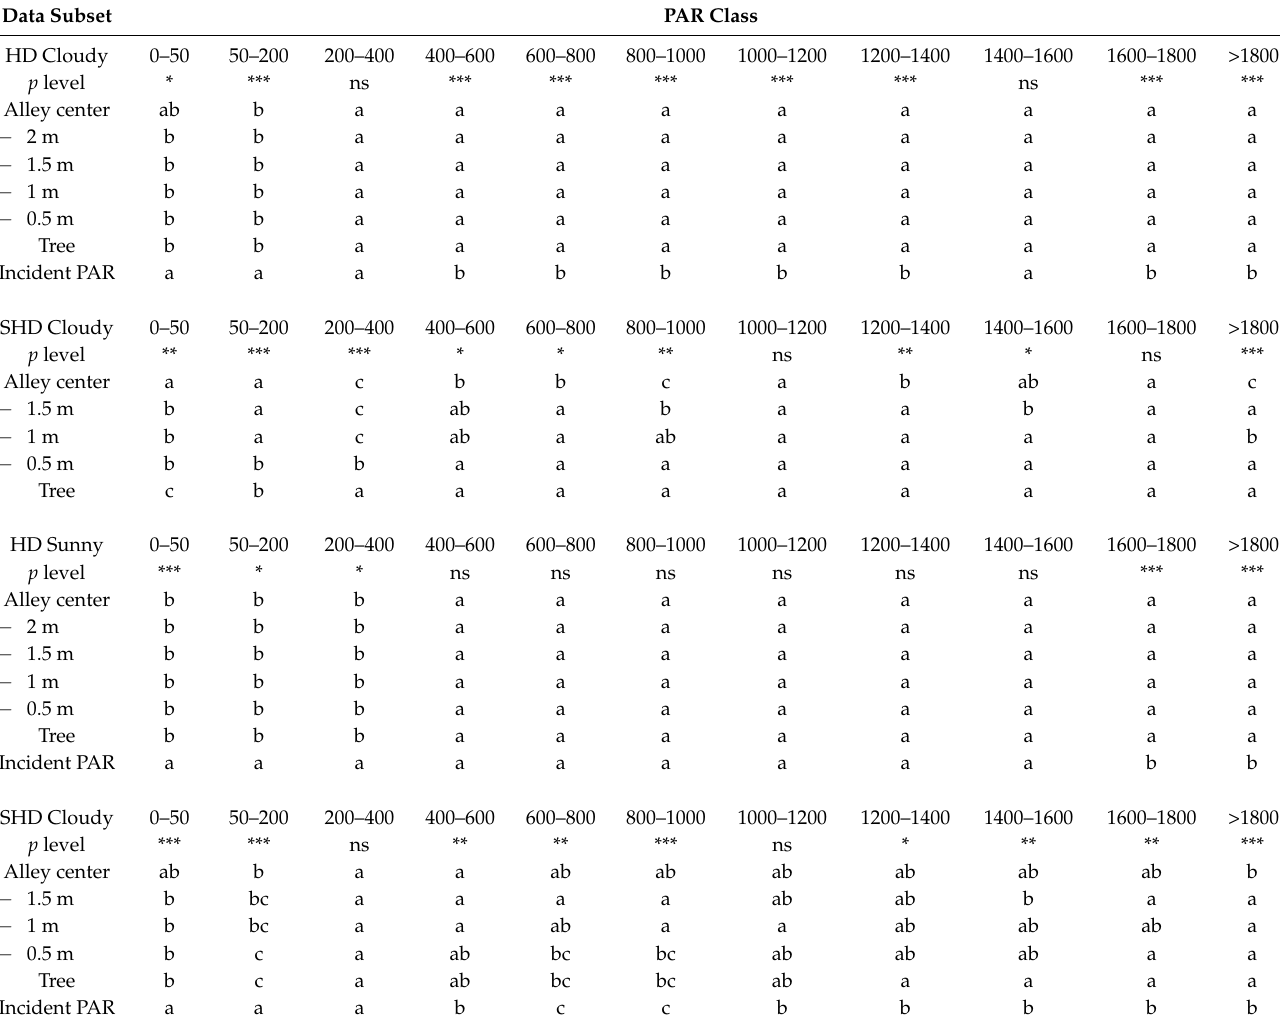
Table 1. Statistics for the position effect, within each PAR class, for the data shown in Figure 4. Statistical significance within each PAR class and within each grouping of data (i.e., HD Cloudy, SHD Cloudy, HD Sunny and SHD Sunny) was tested by analysis of variance (ANOVA, * = p < 0.05; ** = p < 0.01, *** = p < 0.001). When ANOVA gave significant effects, differences between positions were tested using the Student–Newman–Keuls test ( p = 0.05). Different letter within − each PAR class and within each grouping of data indicate significant differences. For the SHD Cloudy data, no statistics are reported for incident PAR as the dataset contained only one